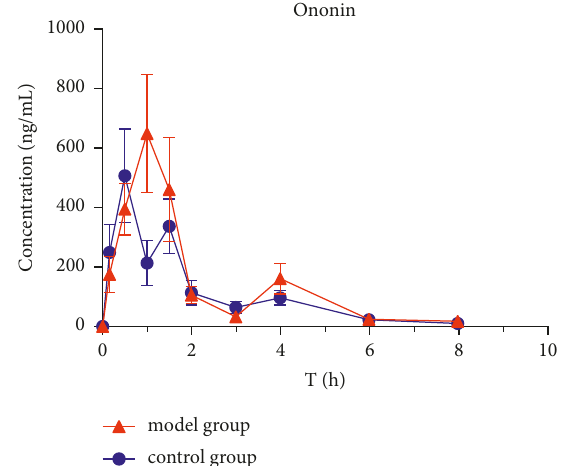
Figure 9: Concentration-time profiles of ononin after HQD ad- ministration ( x ± SD, n � 8).